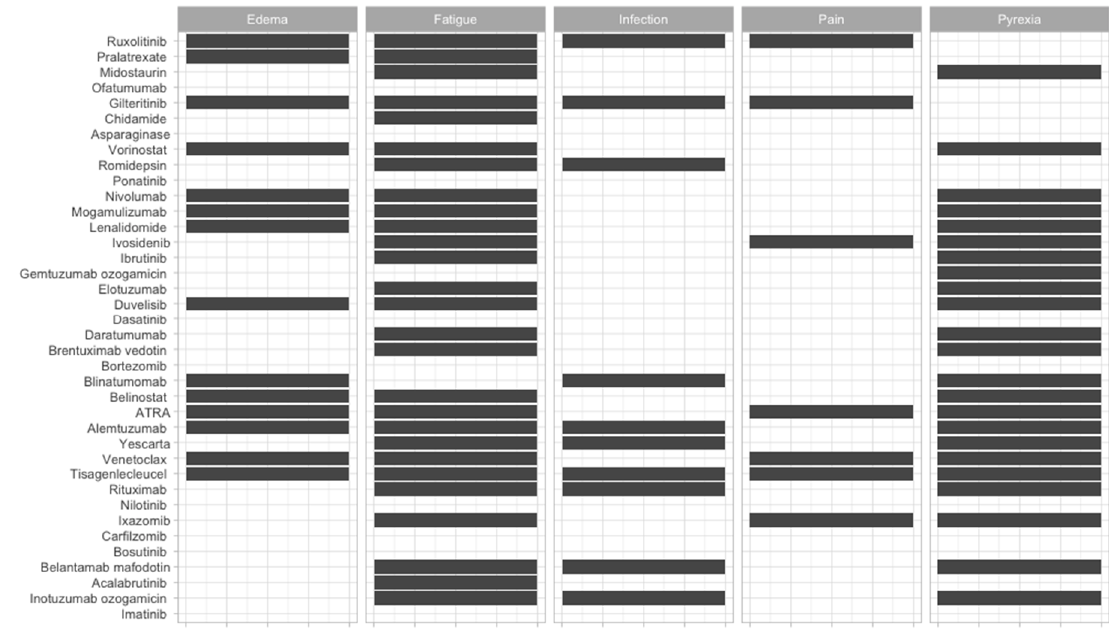
Figure 8. Systemic side-effects of FDA-approved and non-approved drugs for hematological disorders.